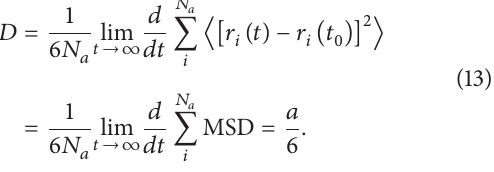
Figure 9: The diffusion coefficient ( 𝐷 ) of oxygen in three inhibitors film at 25 ± 1 ∘